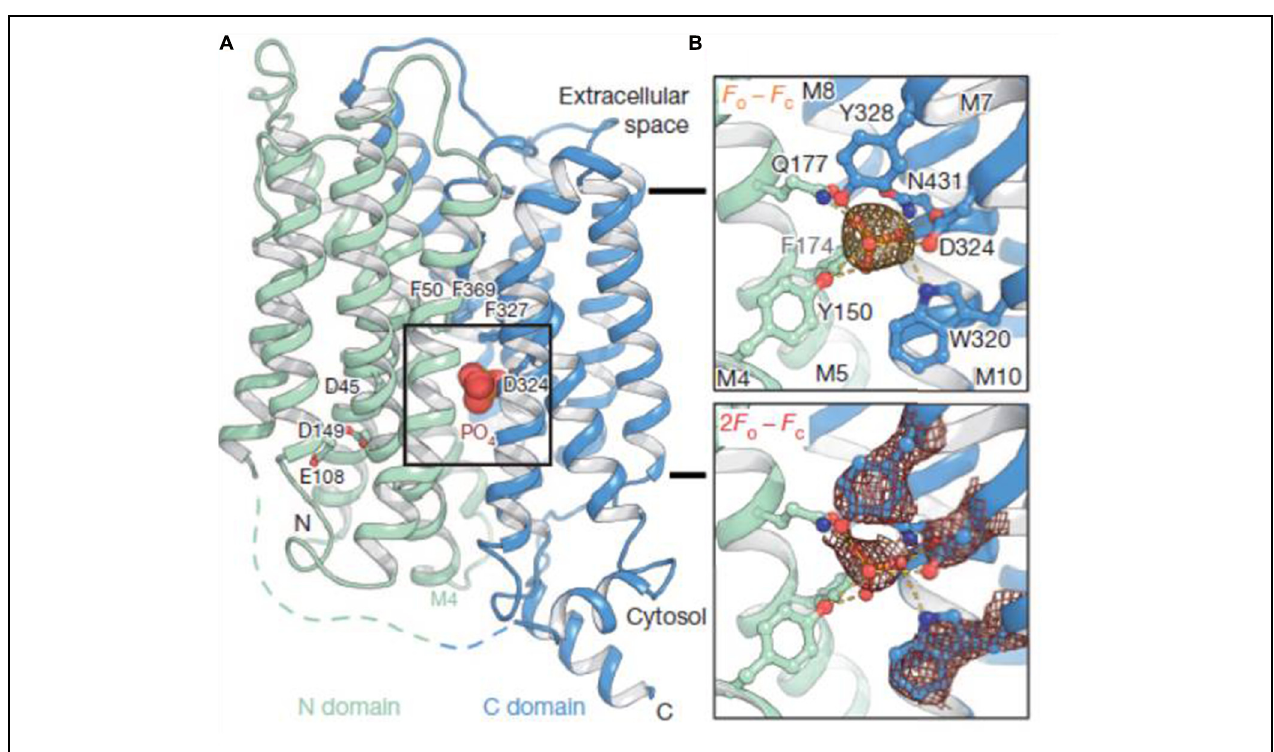
FIGURE 3 | Structure of the high-affinity phosphate transporter, PiPT. The structure represents an inward facing occluded state of the phosphate transporter in complex with phosphate. (A) Phosphate (shown as spheres) is buried in the membrane at the interface between the N domain (pale green) and C domain (blue). Selected residues are shown as sticks. Black bars depict the approximate location of the membrane. (B) The phosphate-binding site with yellow dashes indicating possible hydrogen bonds (2.2–3.8Å distances) to phosphate. Top: the omit 2mFo-DFc density for phosphate is contoured in orange (4s). Bottom: the 2mFo-DFc density for phosphate and selected M7 residues is contoured in red (2s). Reproduced with permission from Macmillan Scientific Publishers Ltd. (London). For more detailed information on PiPT structure please see reference Pedersen et al. (2013).